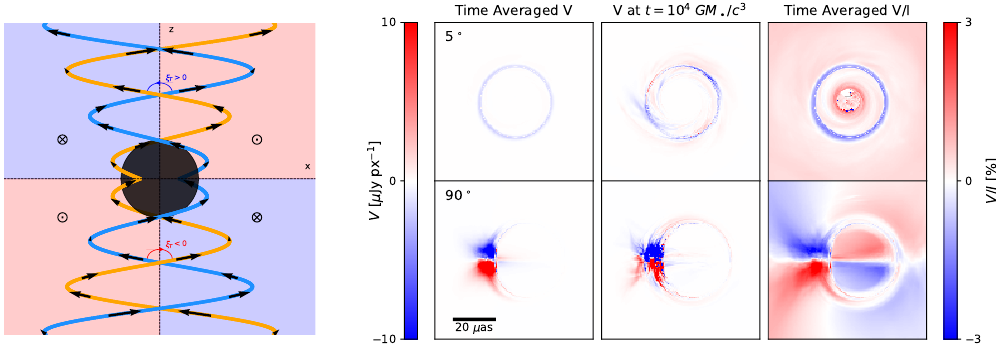
Figure 5. Maps of circular polarization encode properties of the geometry of the magnetic field, both its line-of-sight direction and twist. A cartoon of a generic helical field geometry is depicted on the left. On the right, we plot the circular polarization of a MAD model of M87* at two inclinations. Both are reproduced from Ricarte et al. [37]. The top row depicts a 5 ◦ viewing angle, and the bottom row depicts a 90 ◦ viewing angle. The first column shows the time averaged circularly polarized image, the second column shows the same at a single snapshot, and the third column shows fractional circular polarization. For face-on viewing angles, the photon ring exhibits an interesting sign flip due to Faraday conversion and the sourcing of photons from the opposite side of the disk. For edge-on viewing angles, circular polarization exhibits a “four quadrants” pattern that reflects the line-of-sight magnetic field